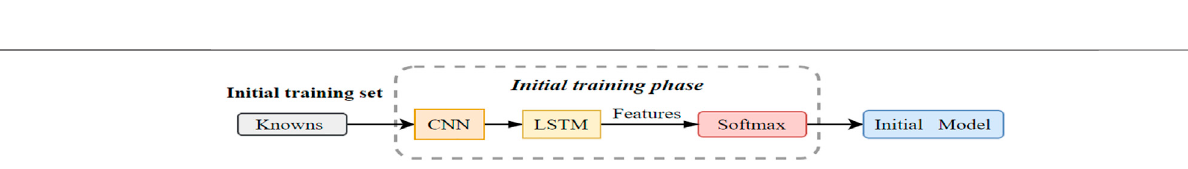
FIGURE 4 | The initial training phase.